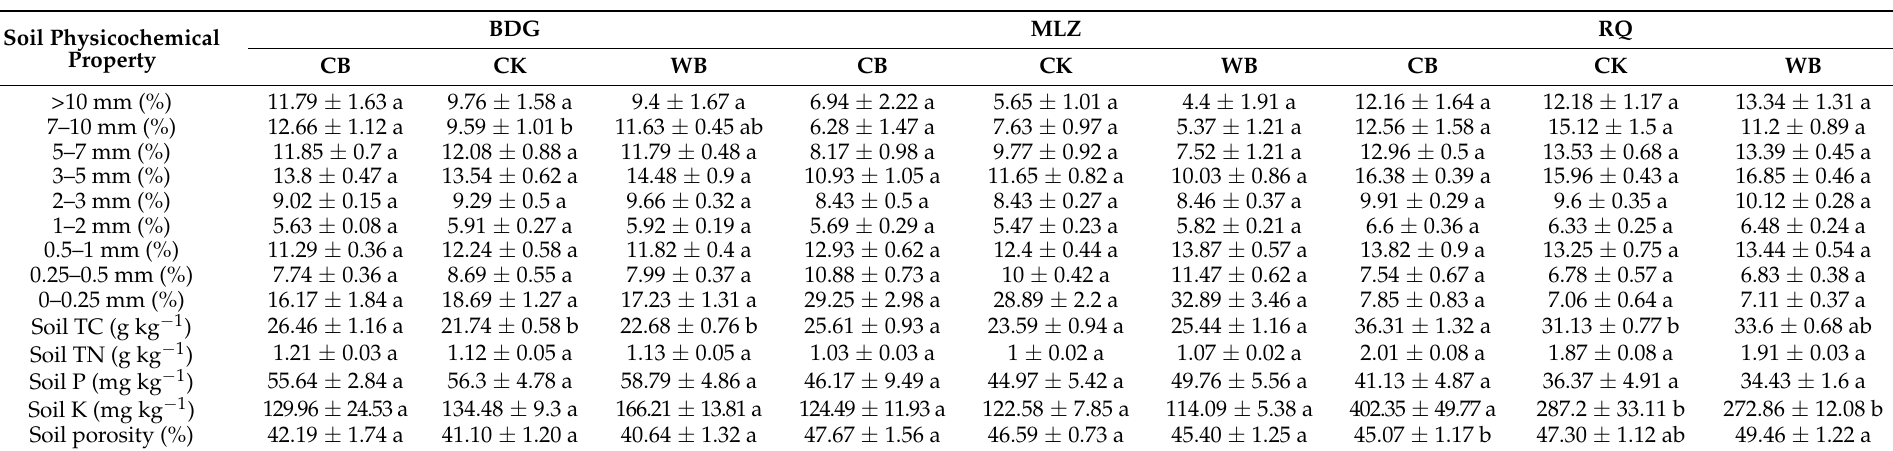
The means ± SE followed by a different letter within each column are significantly different at p < 0.05 using the Duncan-test. Table 3. Soil aggregate size classes, nutrient concentrations, and porosity under treatment of biochar in sandy clay loam (BDG and MLZ) and silty clay loam (RQ)